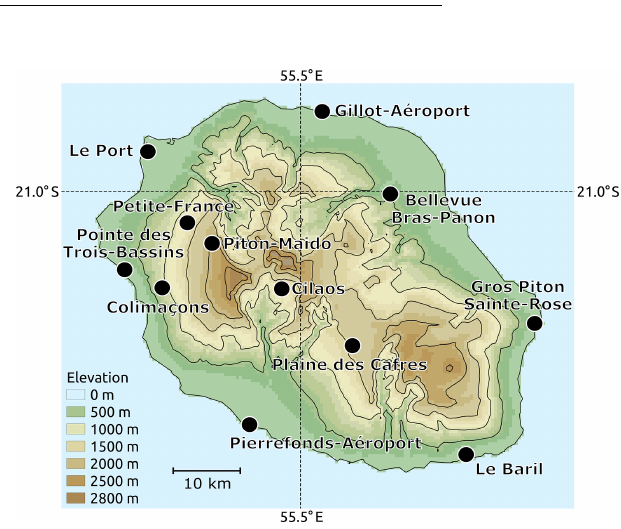
Figure 2. Topography of Réunion Island (21 ◦ S, 55.5 ◦ E) and the locations of the 12 Météo-France pyranometers used for the evalu- ation of the WRF solar irradiance